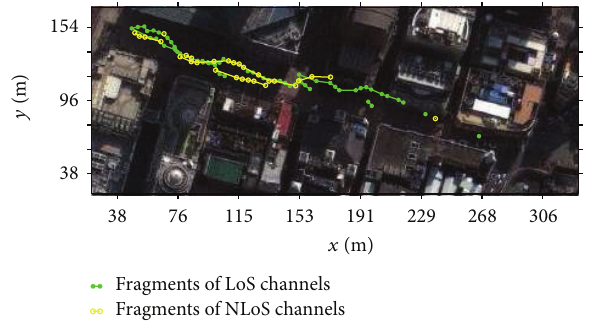
Figure 11: An example of calculating life-distance of LoS and NLoS channels for a NB with the scrambling code number